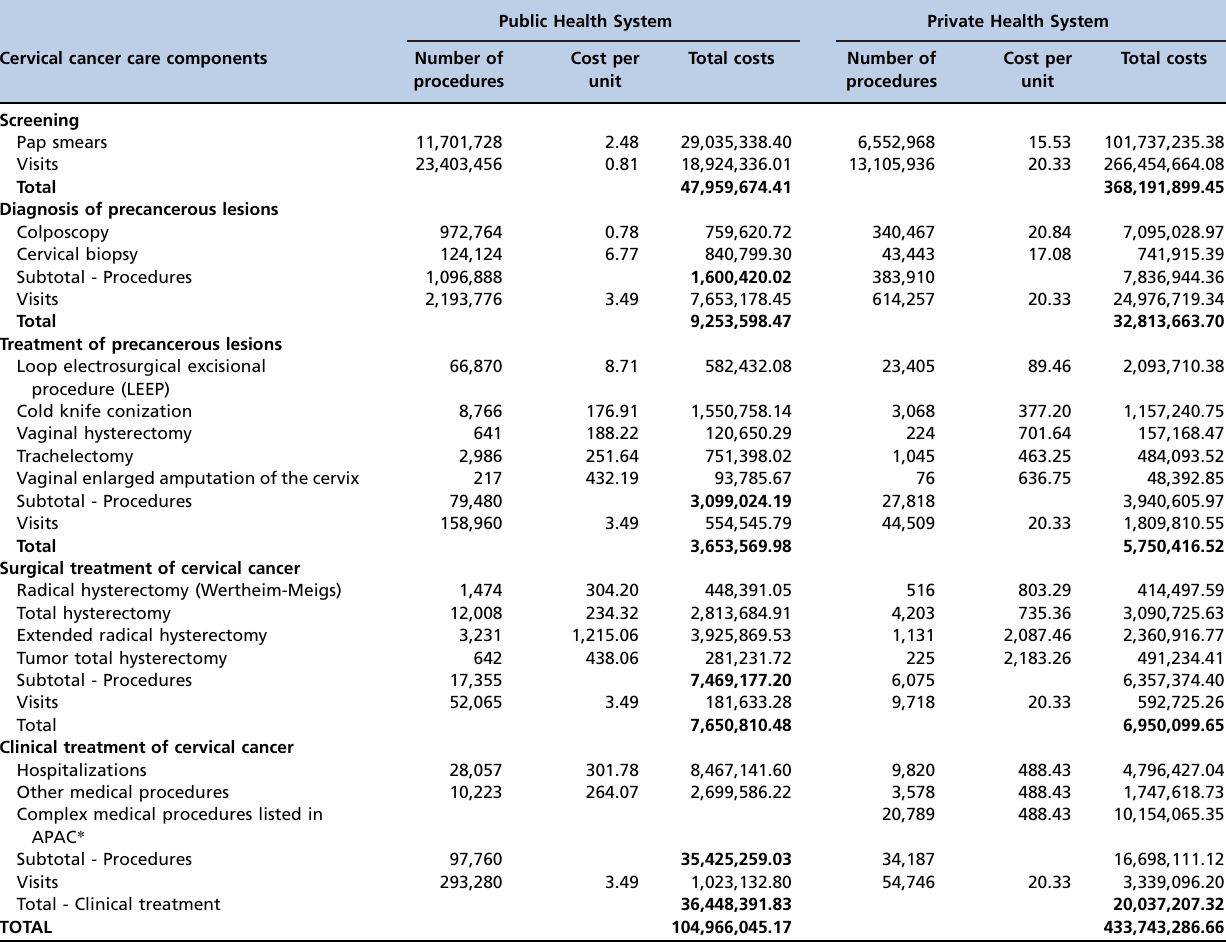
Table 1 - Estimates of direct medical costs for the screening, diagnosis and treatment of precancerous lesions and the diagnosis and treatment of cervical cancer in public and private health systems in Brazil, in 2006 United States dollars (USD).